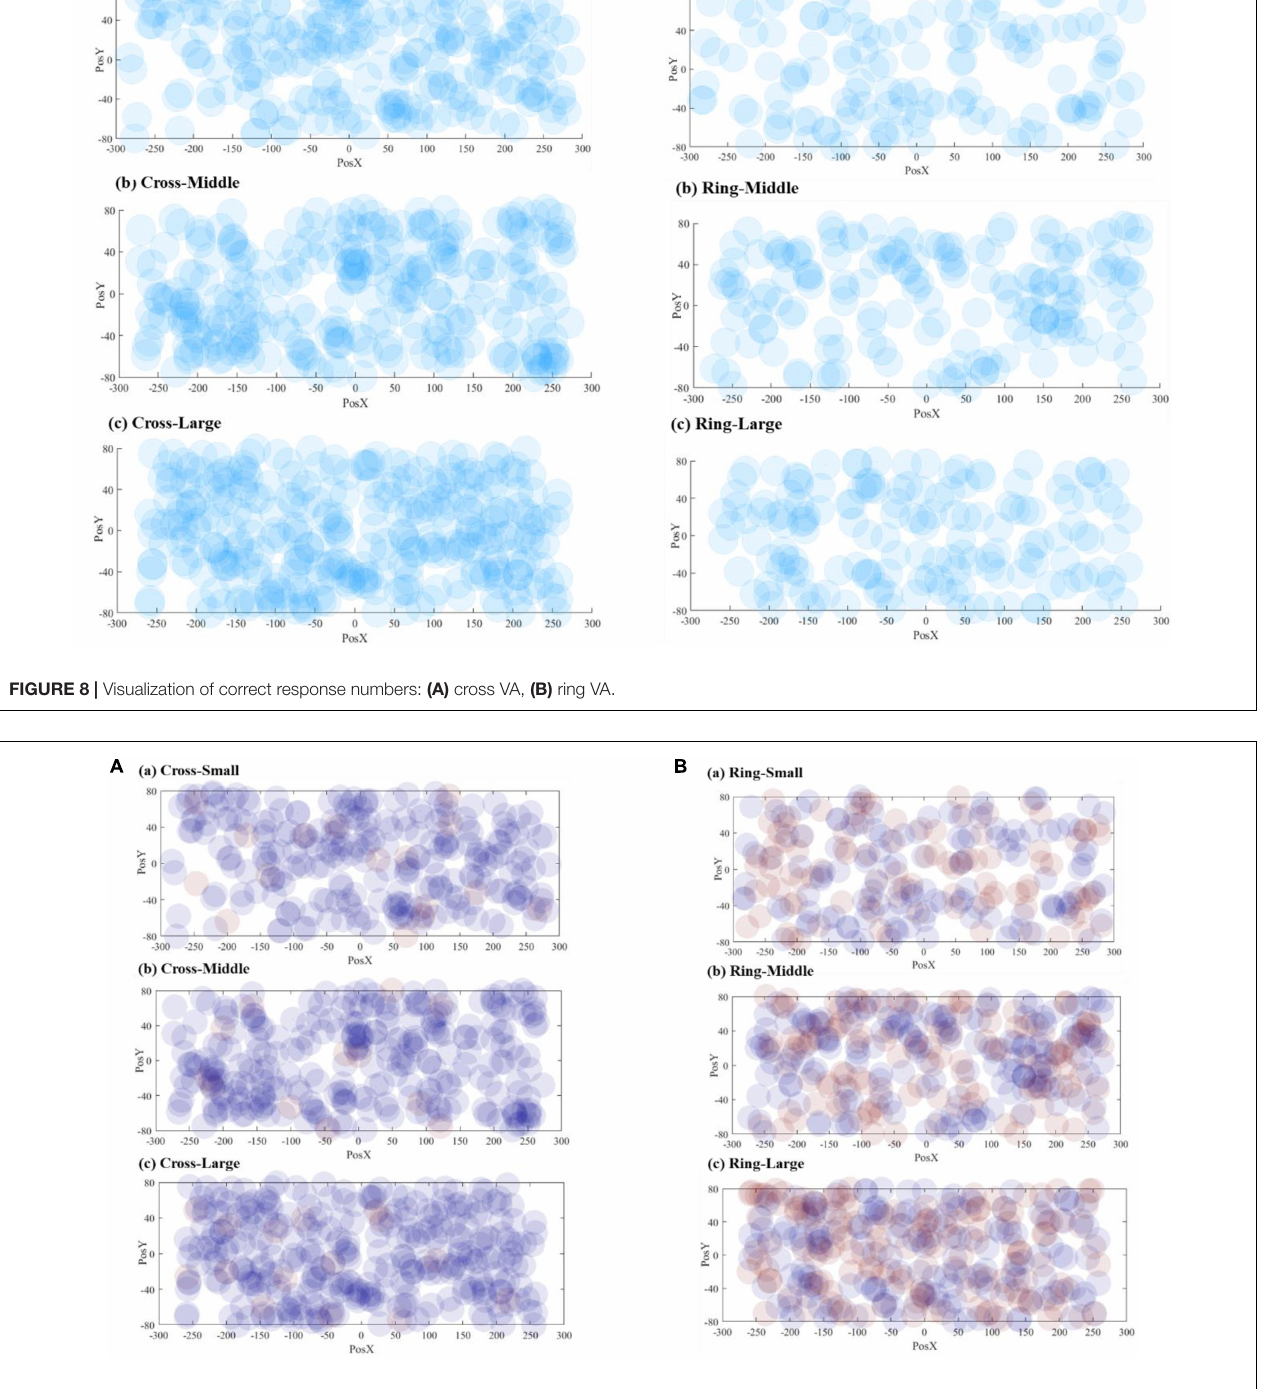
FIGURE 9 | Visualization of all response numbers: (A) cross VA, (B) ring VA.